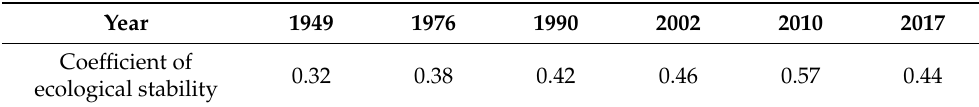
Table 5. Coefficient of ecological stability of the landscape.